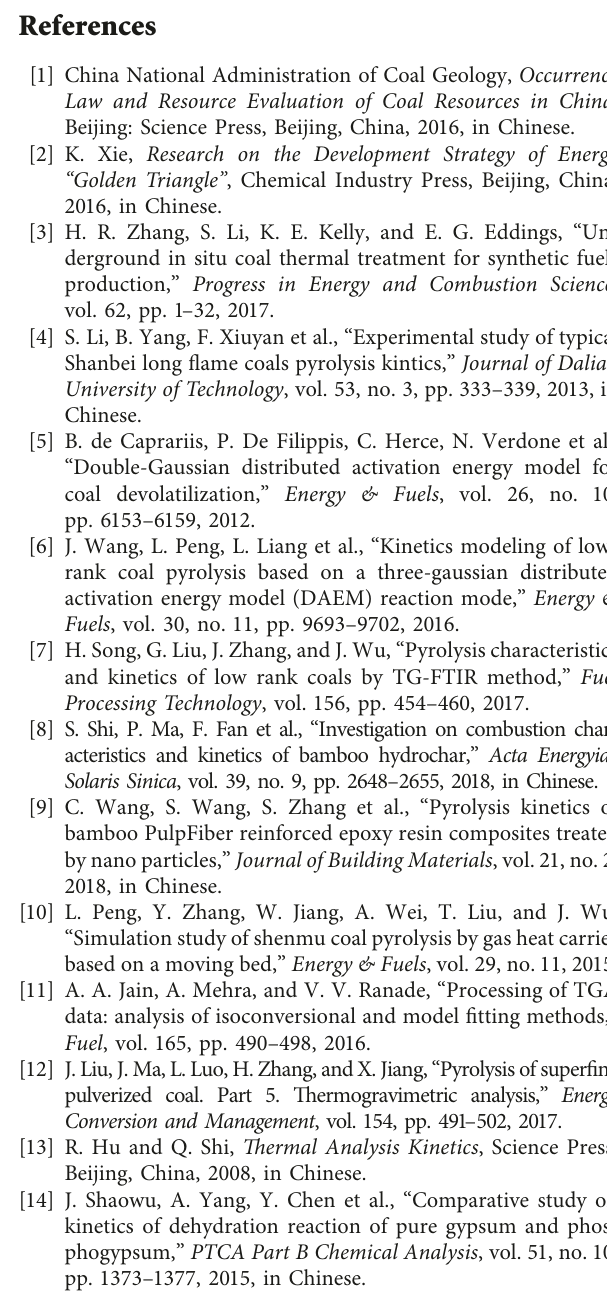
equation (2), respectively, and the kinetic equations of their